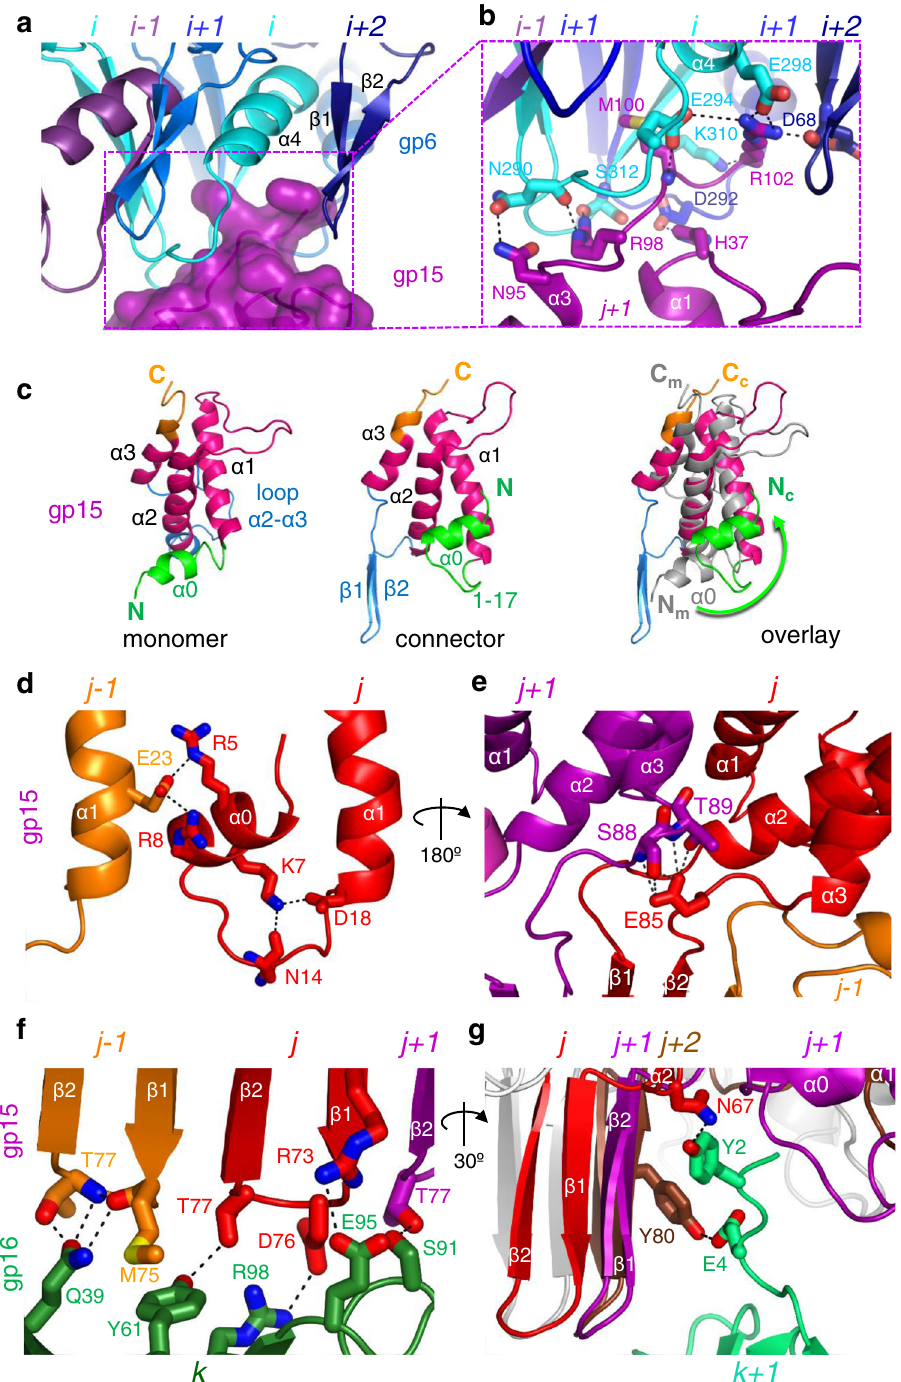
Fig. 3 | Intermolecular interfaces within the SPP1 connector. a gp6-gp15 inter- face. The C-terminus of the gp15 subunit j + 1 (in magenta) interacts with the clip pocket formed by three gp6 subunits shown in cyan ( i ), blue ( i + 1 ) and dark blue ( i + 2 )asinFig.1b.Viewfromtheoutsideoftheconnector. b Zoomedinviewofthe gp6-gp15interactionsoftheoutlined areain a .Interchainhydrogenbondsandsalt bridges between gp6 and gp15 subunits are displayed as dashed lines in black. c Comparison of the assembly-naïve gp15 monomer (left) (PDB 2KBZ) and the gp15 subunit in the connector (centre) superposed through their α -helical core (magenta).Helix α 0isshowningreen,loop α 2- α 3isinblue,andtheC-terminusisin orange. The overlay of the gp15 subunit from the connector with the NMR